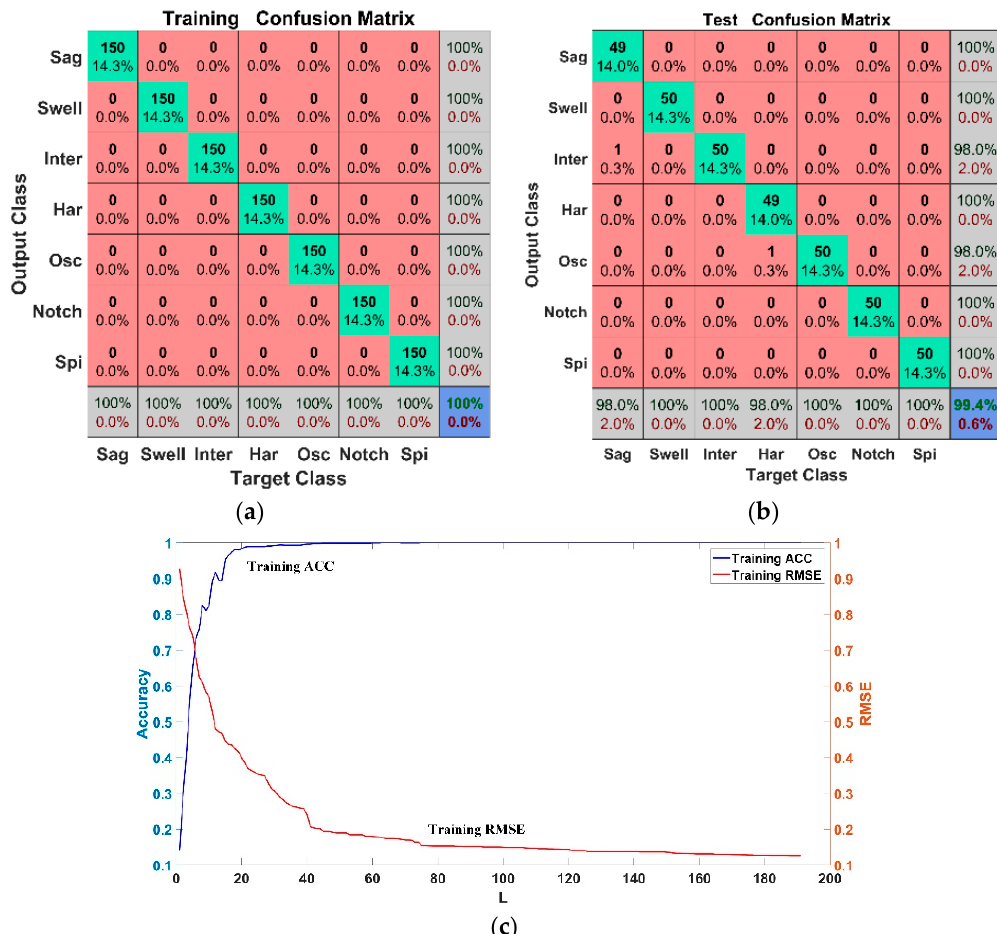
Figure 9. The results of classification: ( a ) training confusion matrix, ( b ) test confusion matrix, and ( c ) accuracy and root mean square error (RMSE) curve of training.